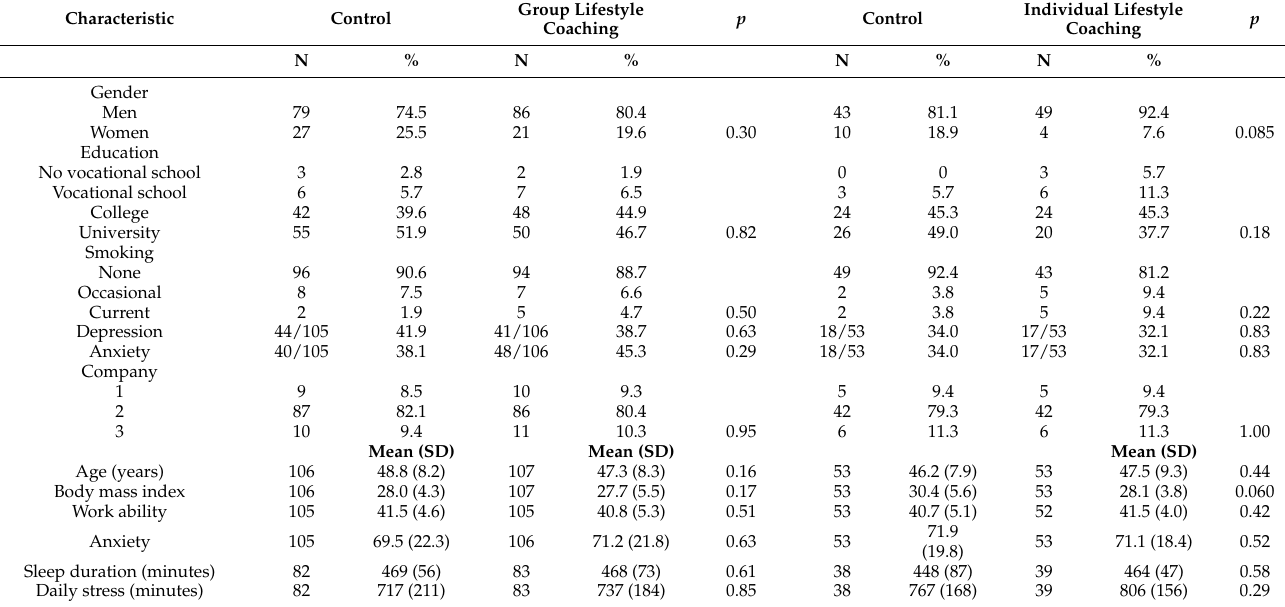
Table 1. The baseline characteristics of the intervention and control groups.